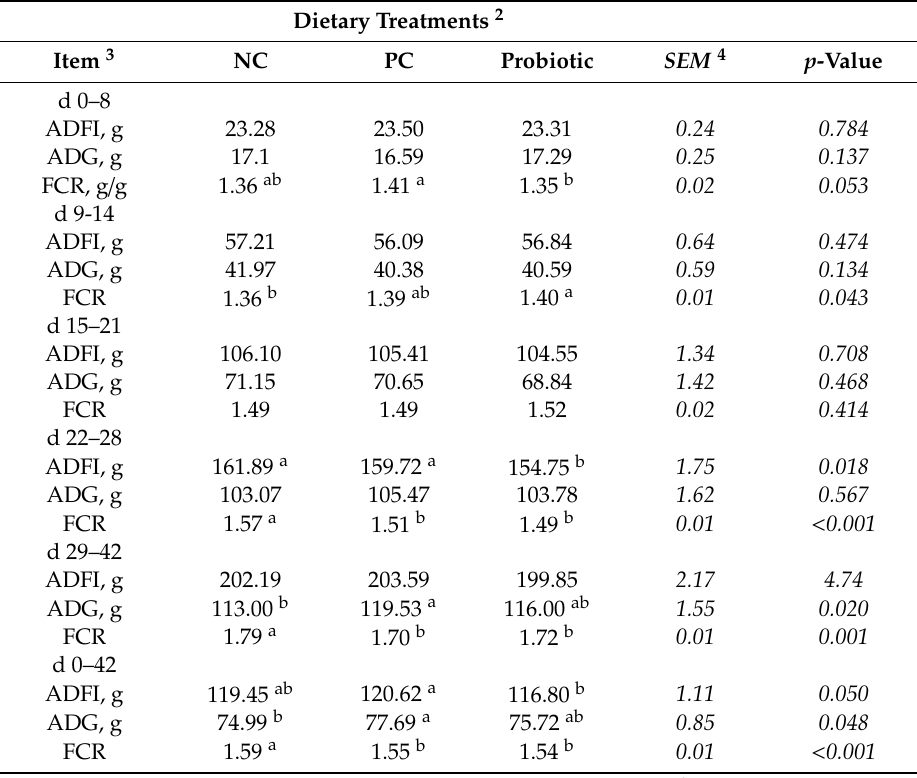
Table 5. E ff ect of antibiotic growth promoter or probiotic supplementation in the diet on broiler performance under a naturally occurring necrotic enteritis model.